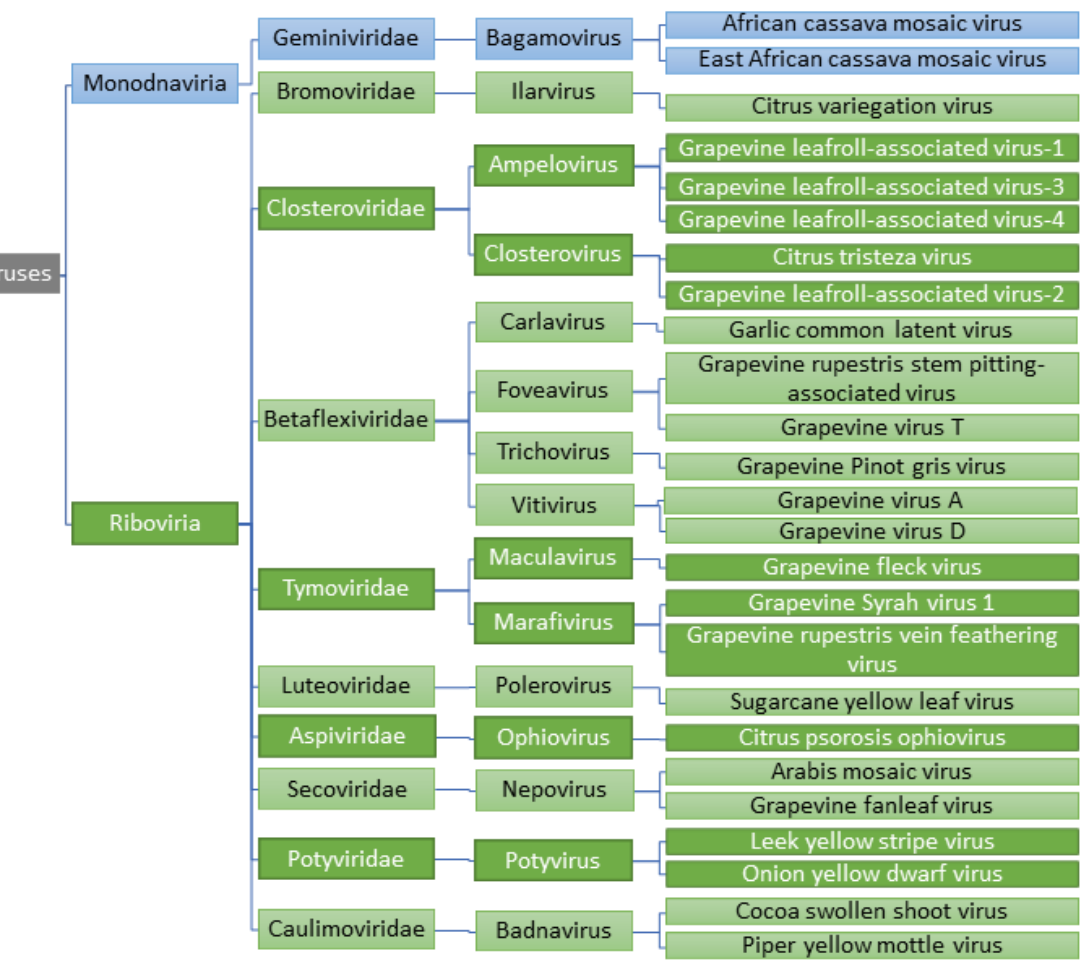
Figure 2. ICTV taxonomy of viroids tested in SE experiments. These species show high diversity in nucleic acid structures with single- (Geminiviri- dae) or double-stranded DNA (Caulimoviridae), and with positive-sense (Betaflexiviri- dae, Bromoviridae, Closteroviridae, Luteoviridae, Potyviridae, Secoviridae, Tymoviri- dae), negative-sense (Aspiviridae), or non-coding single-stranded RNA genomes (Avsun- viroidae, Pospiviroidae). These viruses and viroids are responsible along with others, for the cassava mosaic, citrus psorosis, cocoa swollenshoot, garlic mosaic, grapevine infec- tious degeneration, piper yellow mottle, and sugarcane yellow leaf diseases (Table 1). The